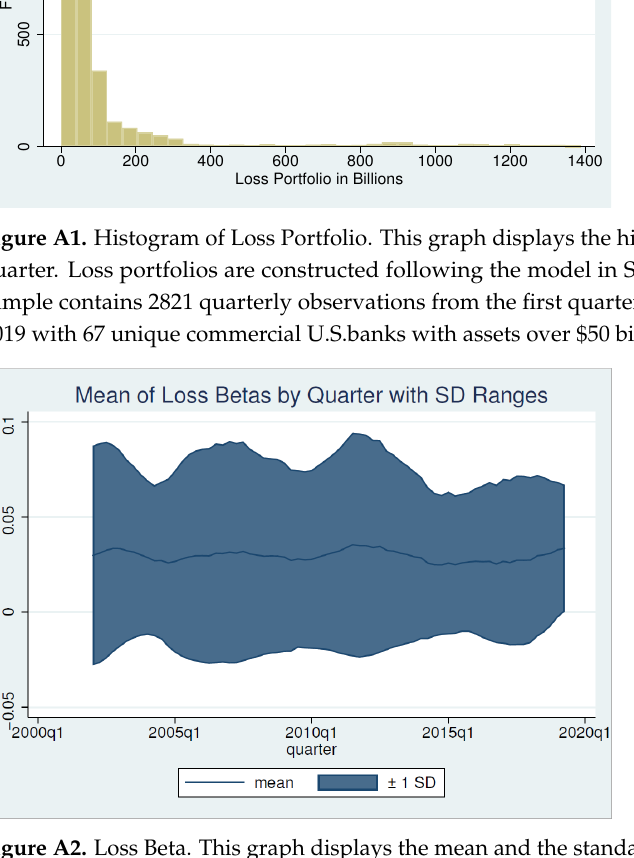
Figure A2. Loss Beta. This graph displays the mean and the standard deviation (SD) of all loss betas in each quarter. Loss betas are constructed following the models in Section 2 using Call Reports. The sample contains 2821 quarterly observations from the first quarter of 2002 to the second quarter of 2019 with 67 unique commercial U.S.banks with assets over $50 billions.